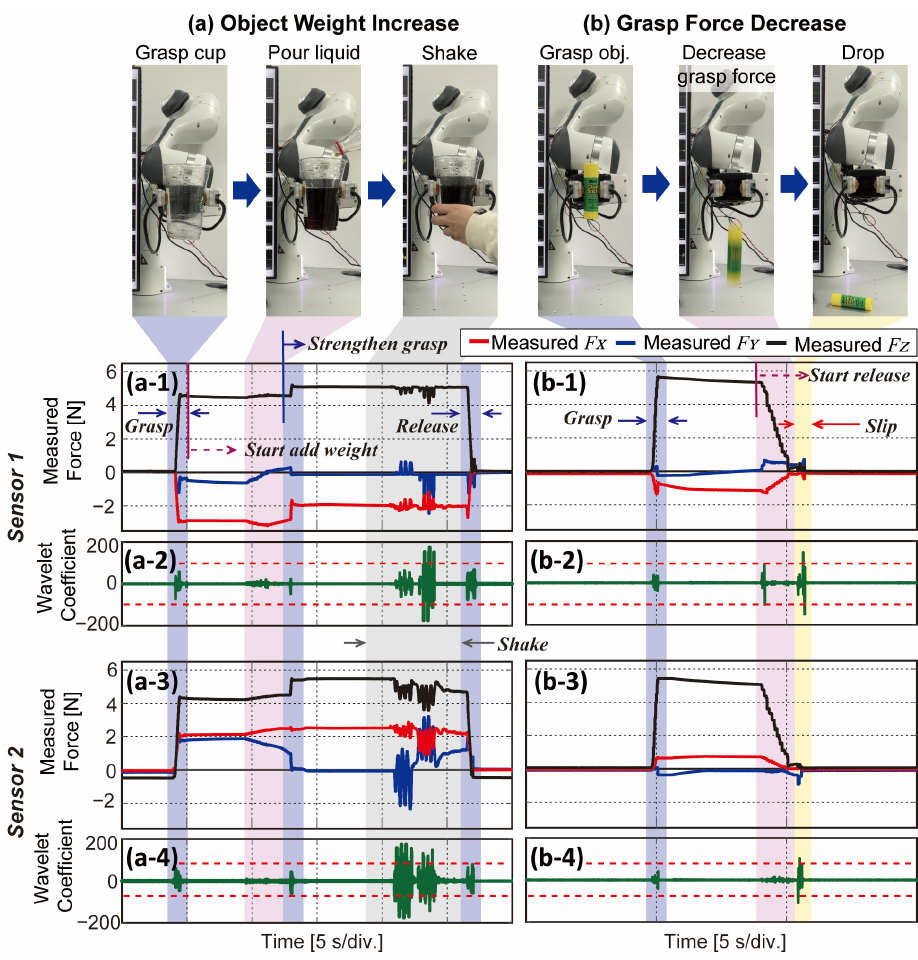
Figure 11. Experiment process and results of ( a ) increasing weight and ( b ) decreasing grasp force. ( a1 , b1 ) Three-axis force measured from sensor 1. ( a3 , b3 ) Three-axis force measured from sensor 2. ( a2 , b2 ) DWT results with threshold from sensor 1. ( a4 , b4 ) DWT results with threshold from sensor 2.